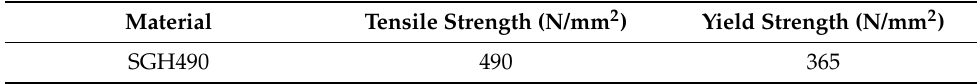
Table 8. Material data of vertical member for structural analysis.